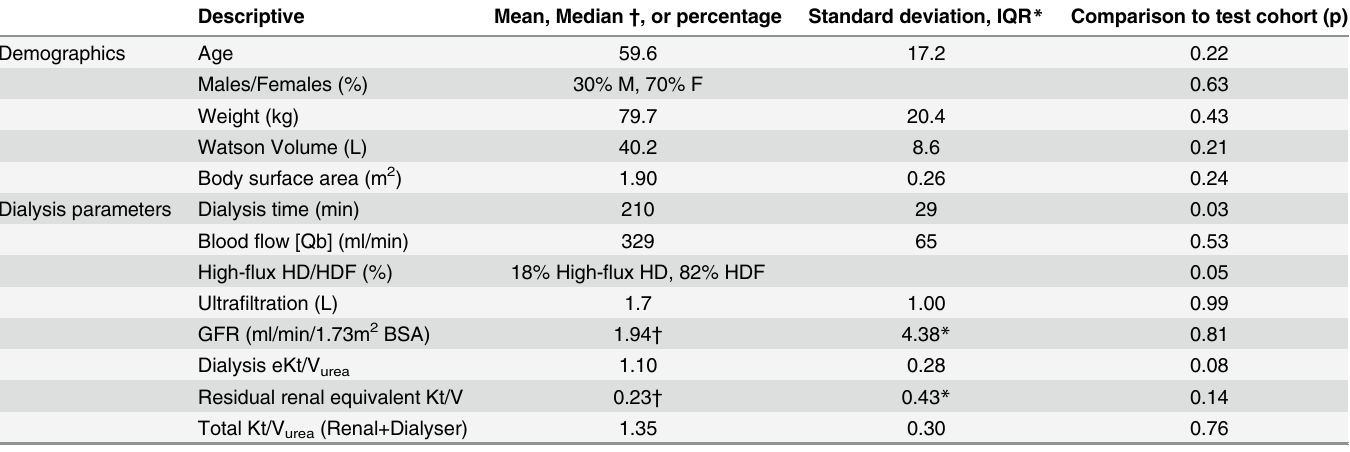
Table 2. Demographics of the validation cohort. Descriptive